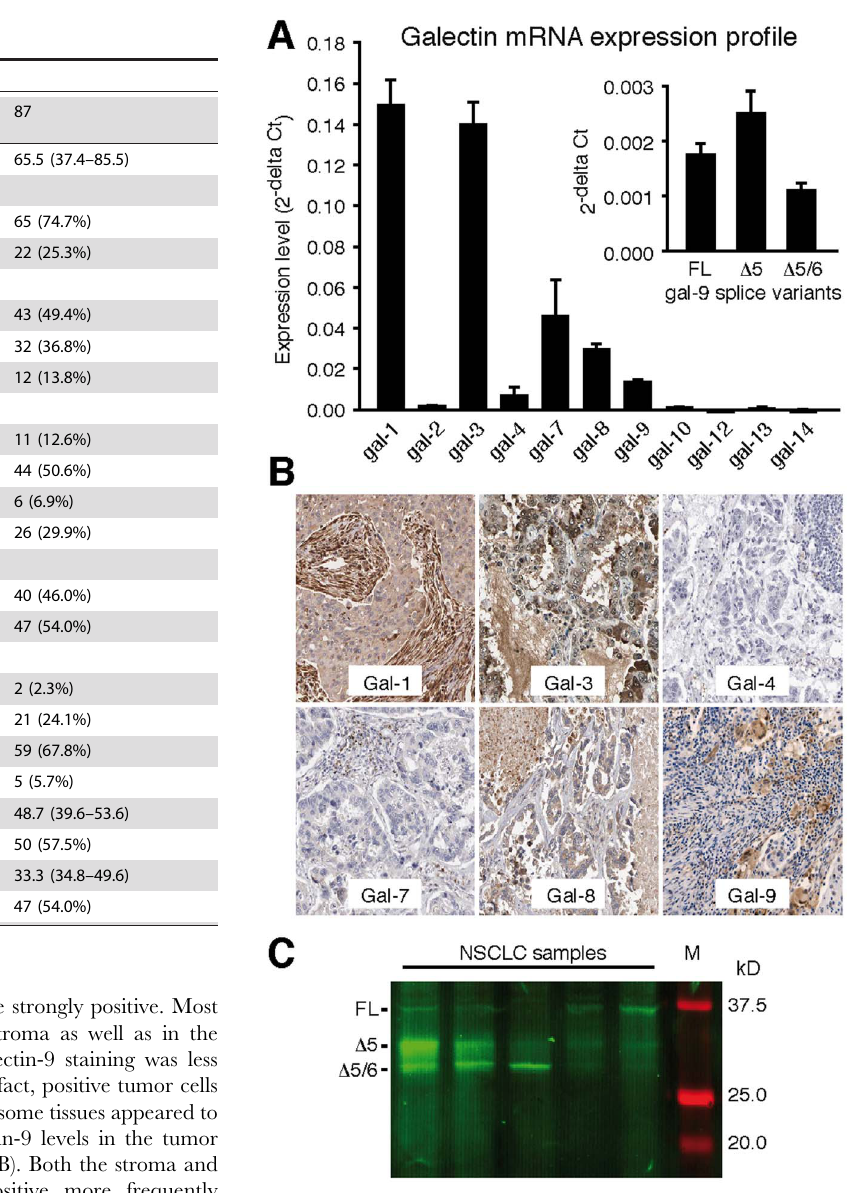
Figure 1. Galectin mRNA expression profile in tumor tissues obtained from early stage non-small cell lung cancer patients (n-=87) (A). The inset shows the expression of the three galectin-9 splice variants. (B) Images of immunohistochemical staining of the galectins with detectable mRNA expression in NSCLC [27]. (C) Western blot analysis of galectin-9 isoform expression in NSCLC tumor tissue from 5 different patients. Three bands at expected molecular weights of galectin-9FL, galectin-9 D 5 and galectin-9 D 5/6 were observed at varying intensities.